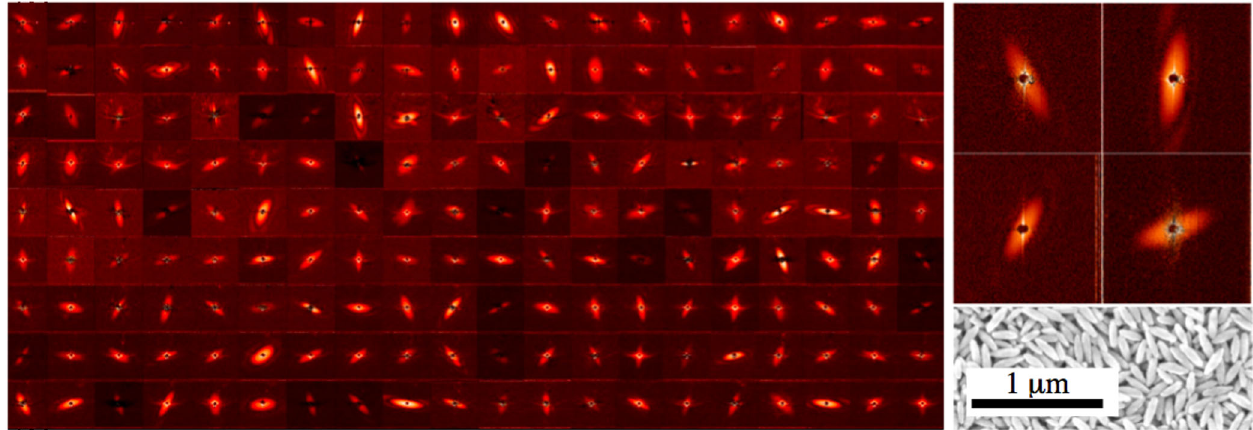
FIG. 3. Diffraction patterns of 180 different single particles (ellipsoidal 50 nm (cid:1) 200 nm iron oxide nanoparticles) in unknown random orientations collected at FLASH, 7 nm wavelength, 10 fs, 10 12 ph = pulse . Magnified versions of four diffraction patterns are shown on the top right. Scanning electron micrograph of particles (bottom